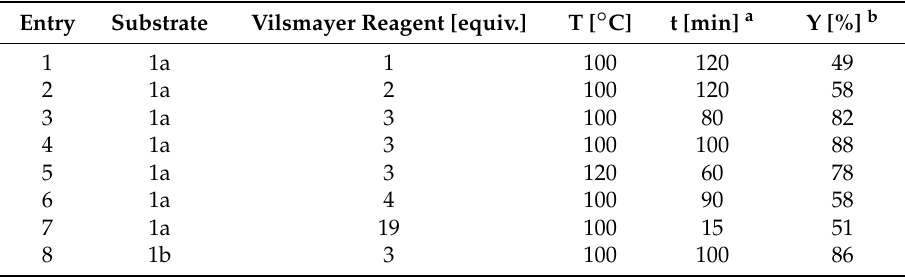
Table 1. Optimization of microwave-assisted Vilsmayer’s